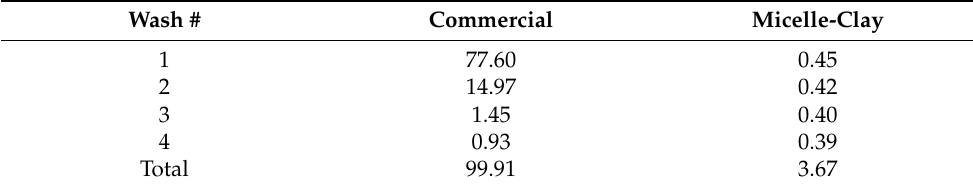
Table 2. Sulfosulfuron release in the “funnel” experiment (% of total